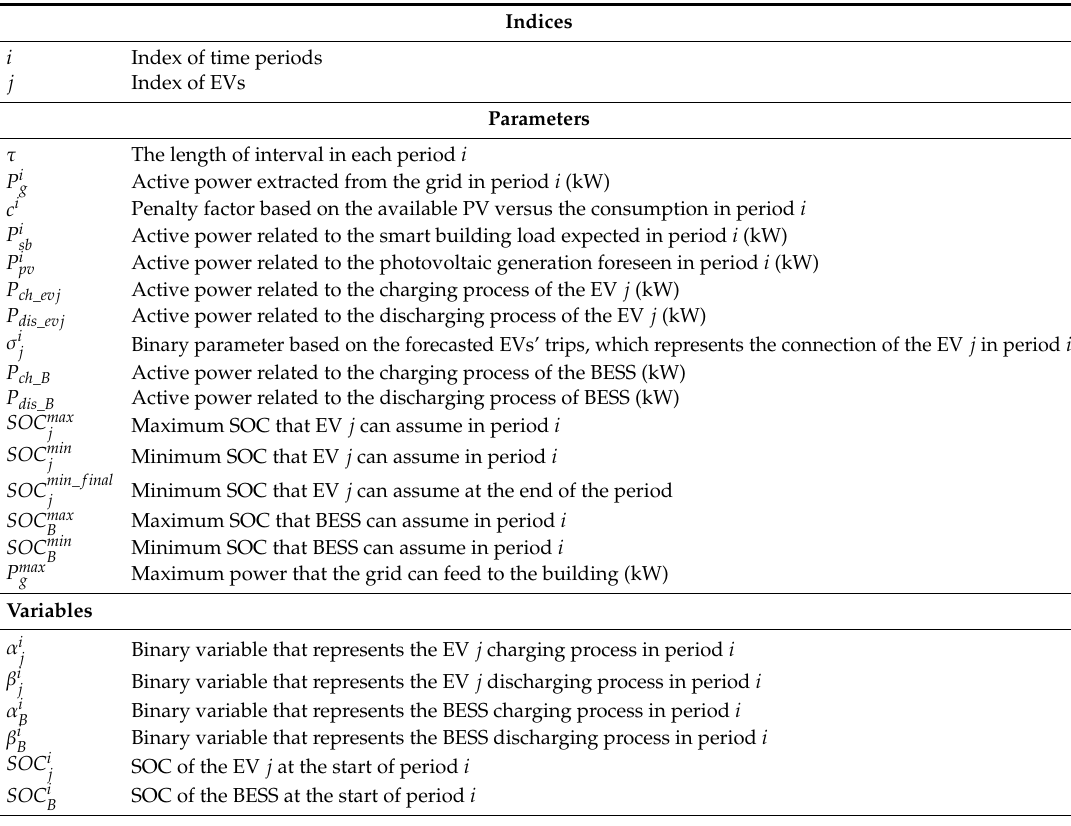
Table 1. Nomenclature of the mathematical formulation.